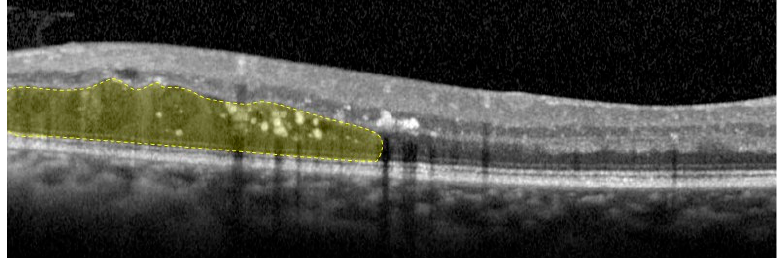
Figure 1. Example of OCT image with the DRT edema presence